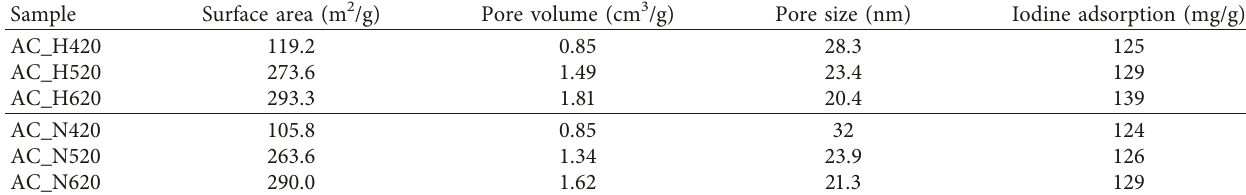
Table 2: Surface areas, pore characteristics, and iodine adsorption of carbon catalysts. Sample Surface area (m 2